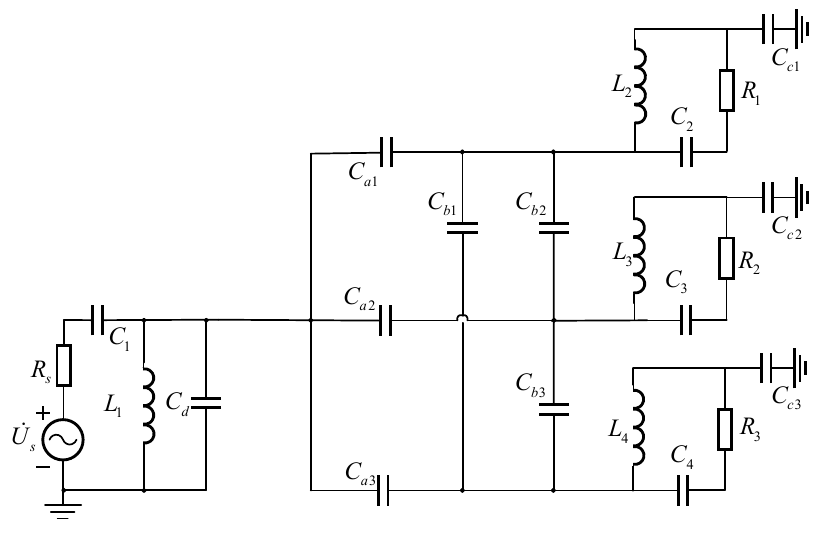
Figure 2. DWPT system equivalent circuit model.